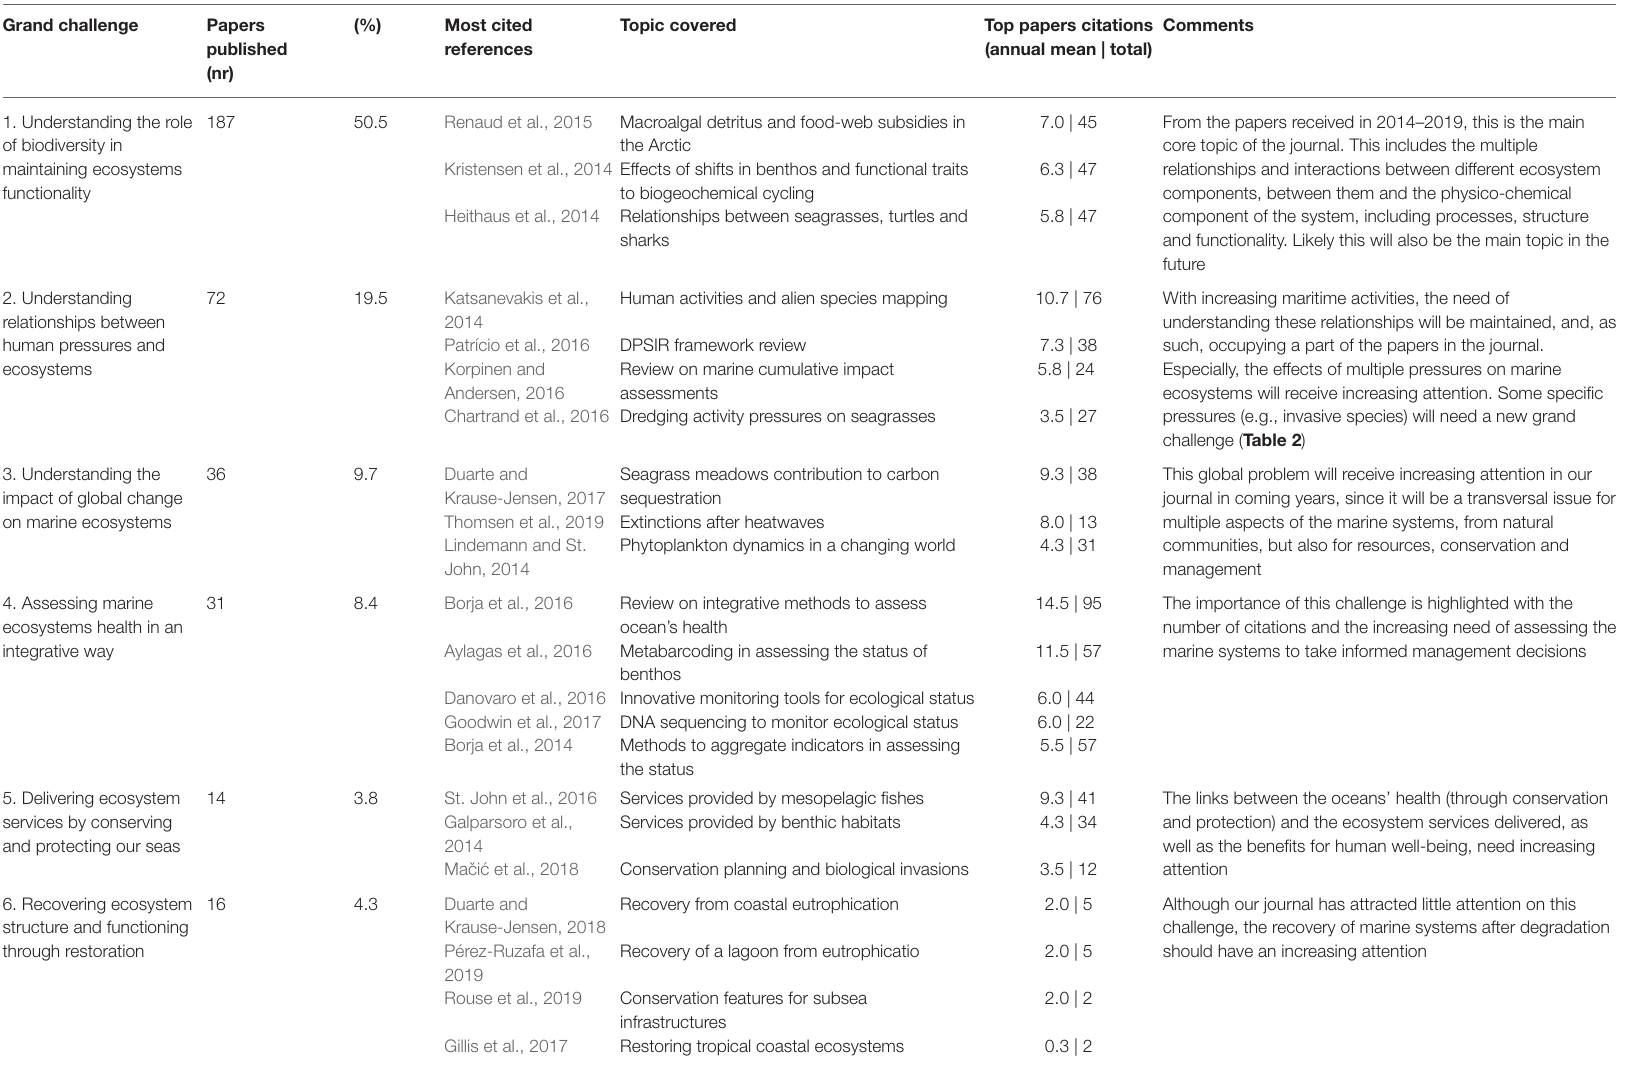
TABLE 1 | Grand Challenges in Marine Ecosystems Ecology, as defined by Borja (2014), number of papers published (and percentage) on each challenge in Frontiers in Marine Science (section Marine Ecosystems Ecology), topics covered by the most cited references for each challenge, considering mean annual citations per paper (excluding self-citations from all authors for the period 2014–2019) and/or total number